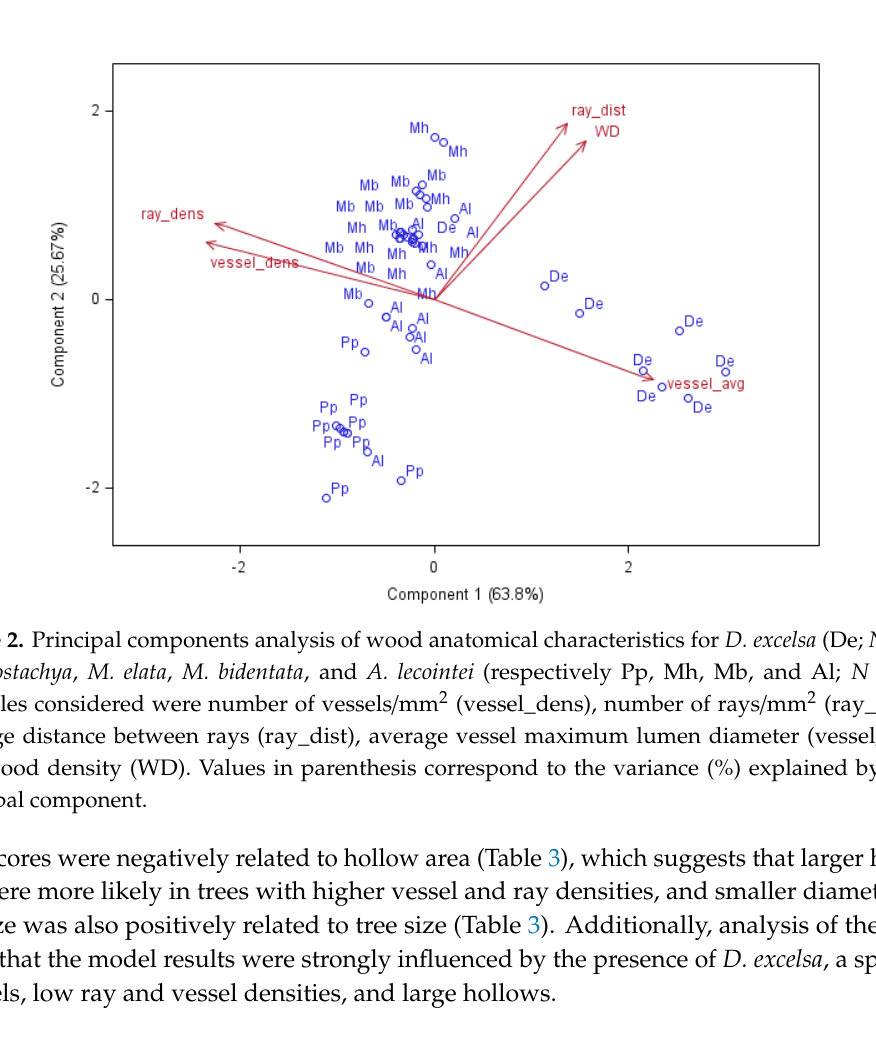
Table 3. Regression with the two most important principal components (PC) for heartwood anatomical traits on hollow area.